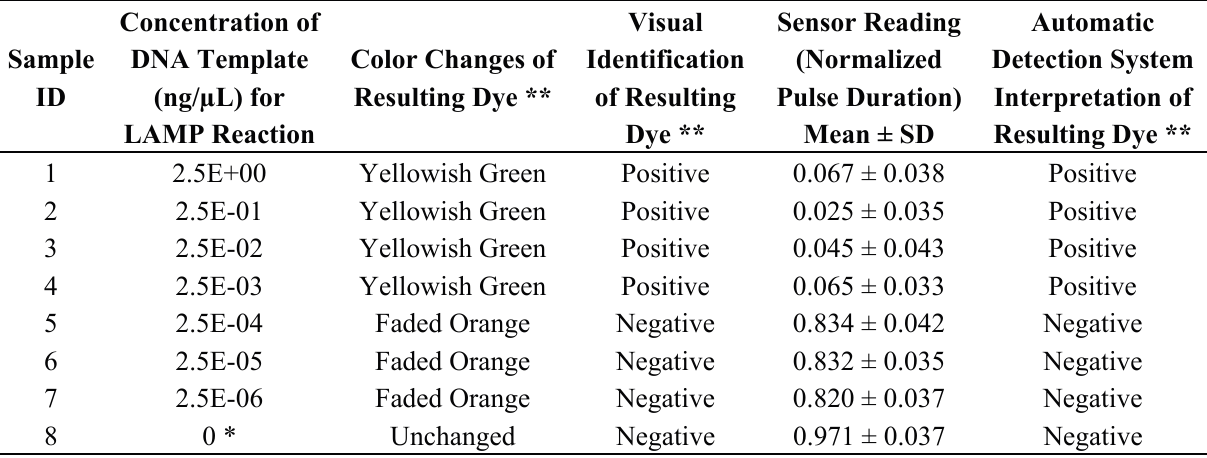
Figure 6. Naked-eye inspection ( A ) Resulting dye (26 µL) of LAMP amplicons (25 µL) and SYBR Green I (1 µL) in ambient light. ( B ) Microfluidic CD loaded with the resulting dye. Table 1. Sensitivity test results of the endpoint detection system at different concentration of Salmonella DNA